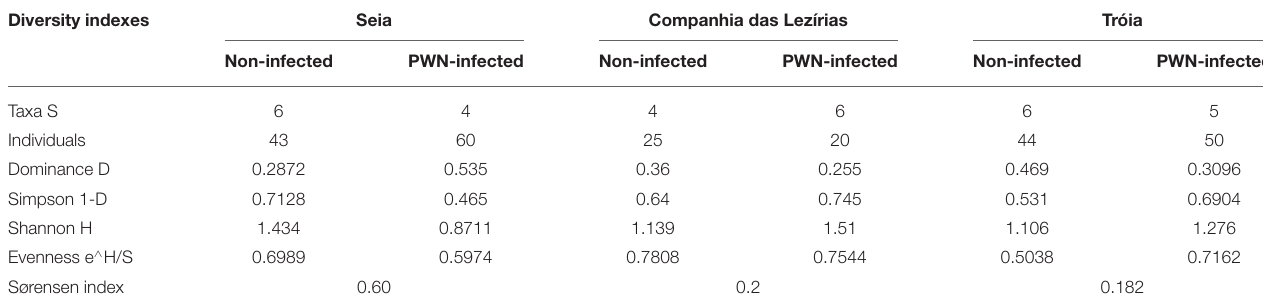
TABLE 2 | Ecological diversity indexes (taxa = order) of fungal communities from non-infected and PWN-infected Pinus pinaster trees sampled. Diversity indexes Seia Companhia das Lezírias Tróia Non-infected PWN-infected Non-infected PWN-infected Non-infected